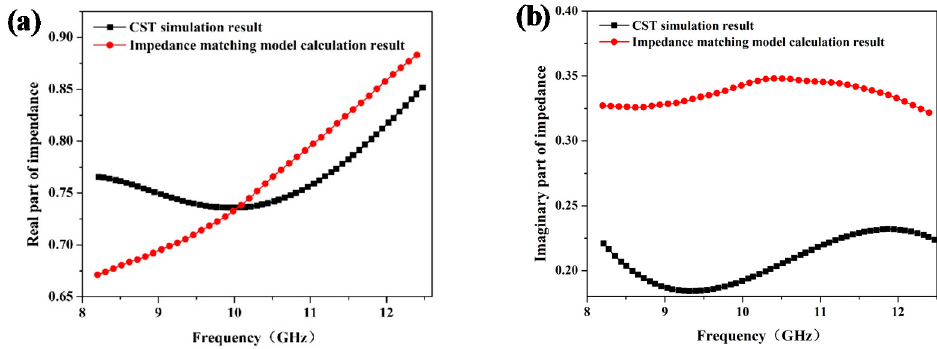
Figure 6. Real ( a ) and imaginary ( b ) part of impedance obtained from the CST simulation result and impedance matching model result.